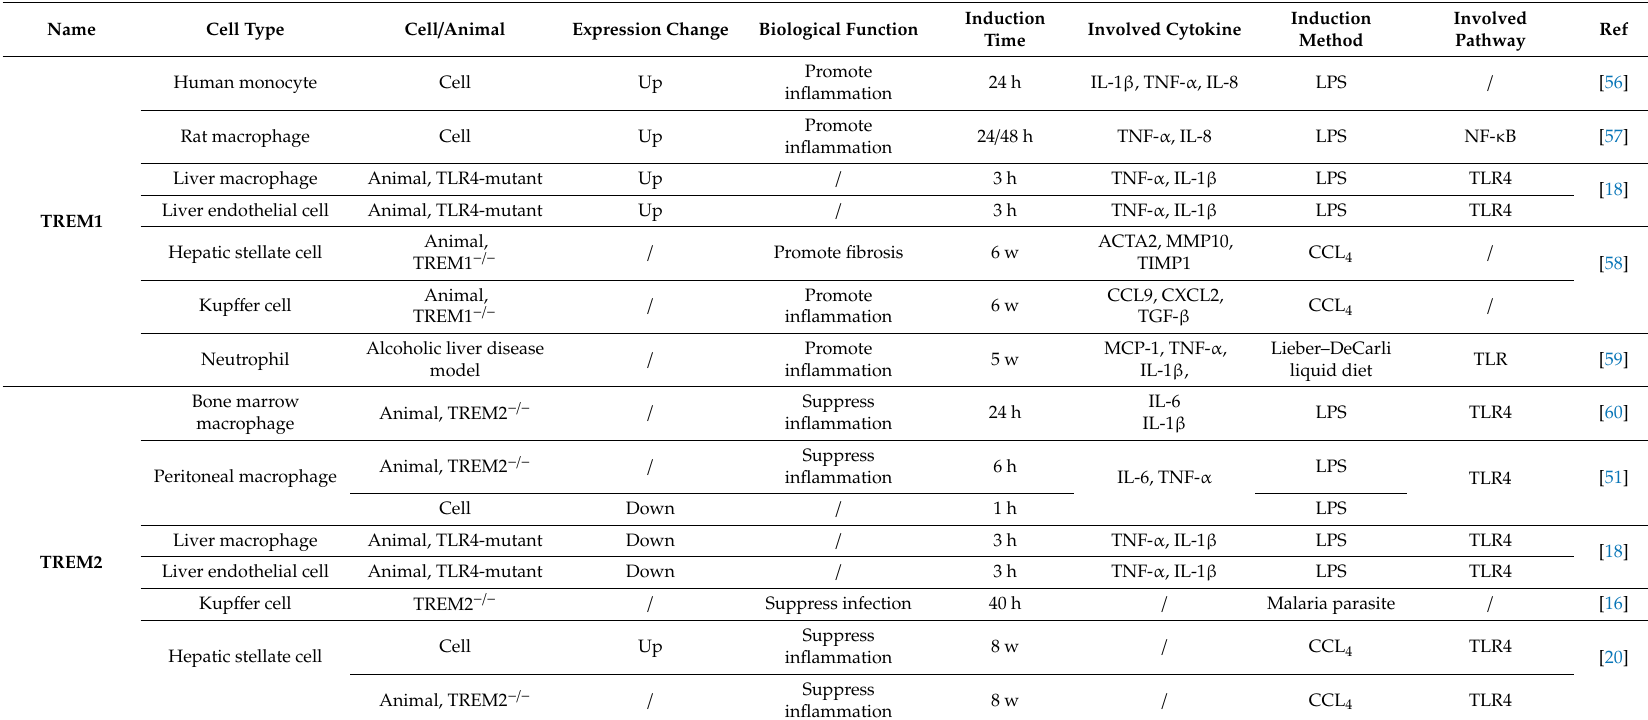
Table 1. The expression of TREM1 and TREM2 in liver-related immune